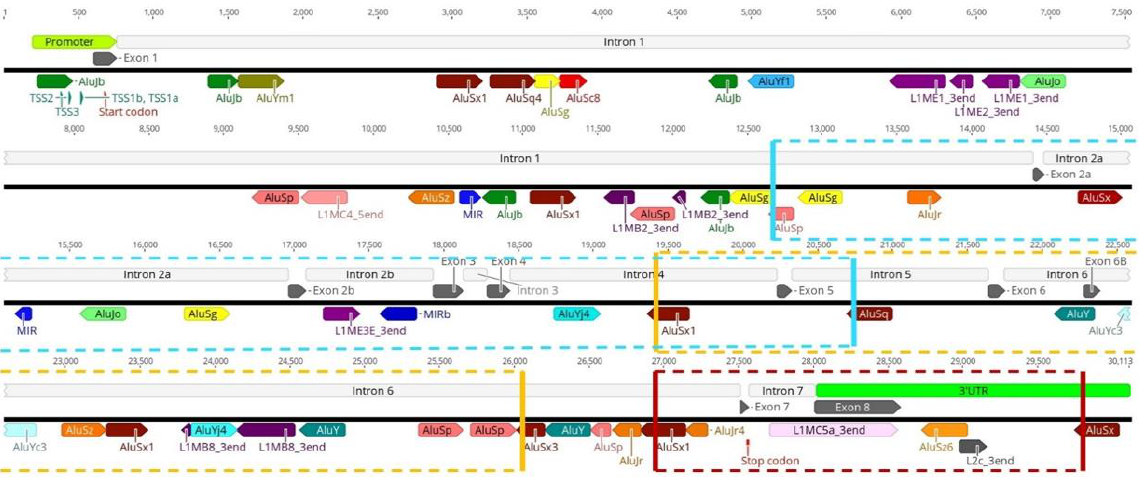
Figure 11. Identification of Alu-mediated partial deletions within SMN1 . The several Alu-derived repeats existent in SMN1 introns provide a fertile source of Alu/Alu recombination events, known to lead to gene deletions. To date, three Alu-mediated deletion events were reported in SMN1 . The more common deletion involving exon 7 and 8 is represented by a red box. A deletion event first described by Wirth et al. [37] involving exons 5 and 6 is indicated by a yellow box. Lastly, the more recently reported Alu-mediated deletion in SMN1 is highlighted by a blue box.